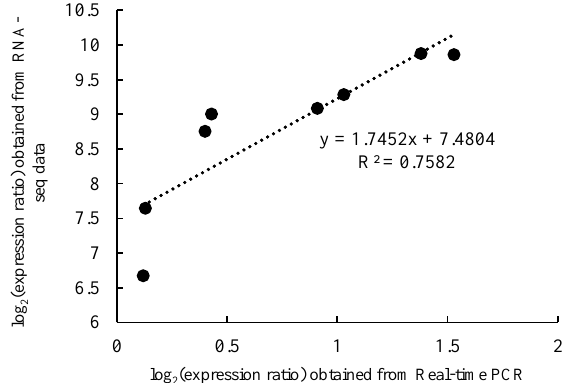
Figure 8. Correlation analysis of gene expression levels obtained from RNA-seq data and qRT – PCR data. Note: The y values represent log 2 (FPKM) from RNA-seq, and the x values represent - (ΔΔCt) from qRT – PCR.